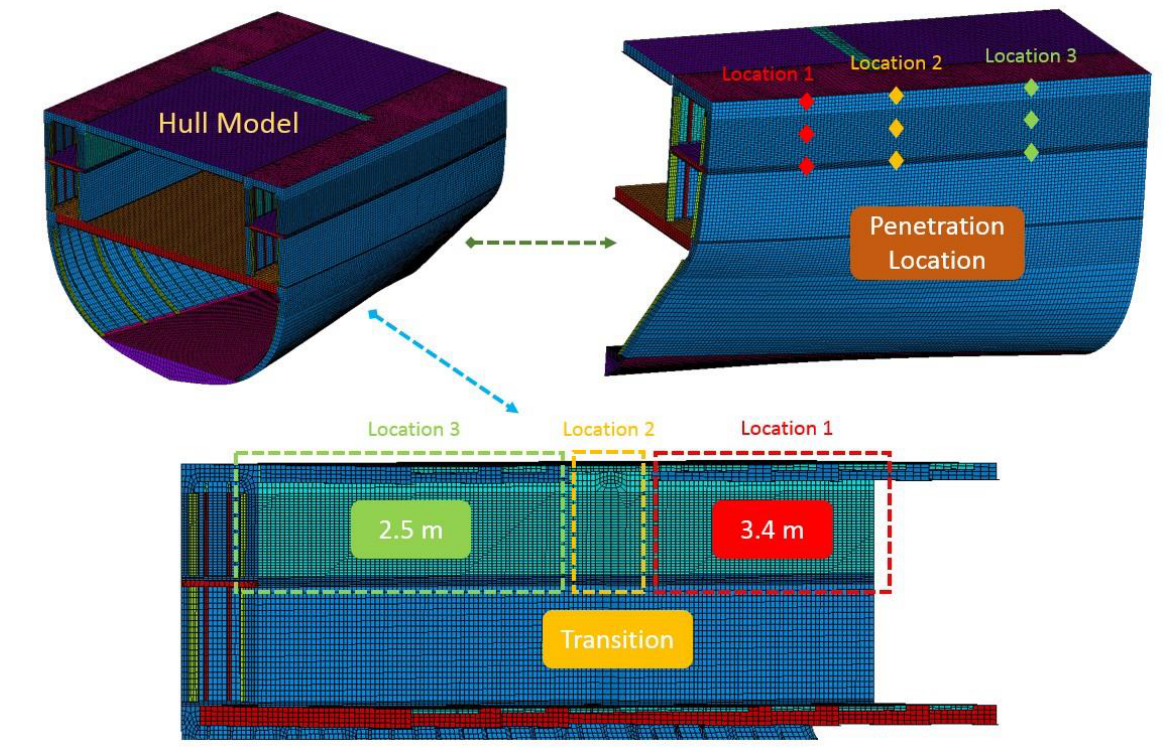
Figure 8: Penetration locations on struck ship DSS